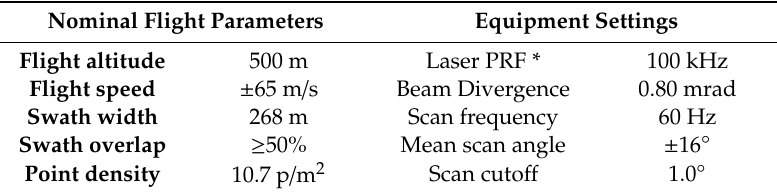
Table 1. LiDAR platform and sensor parameters.